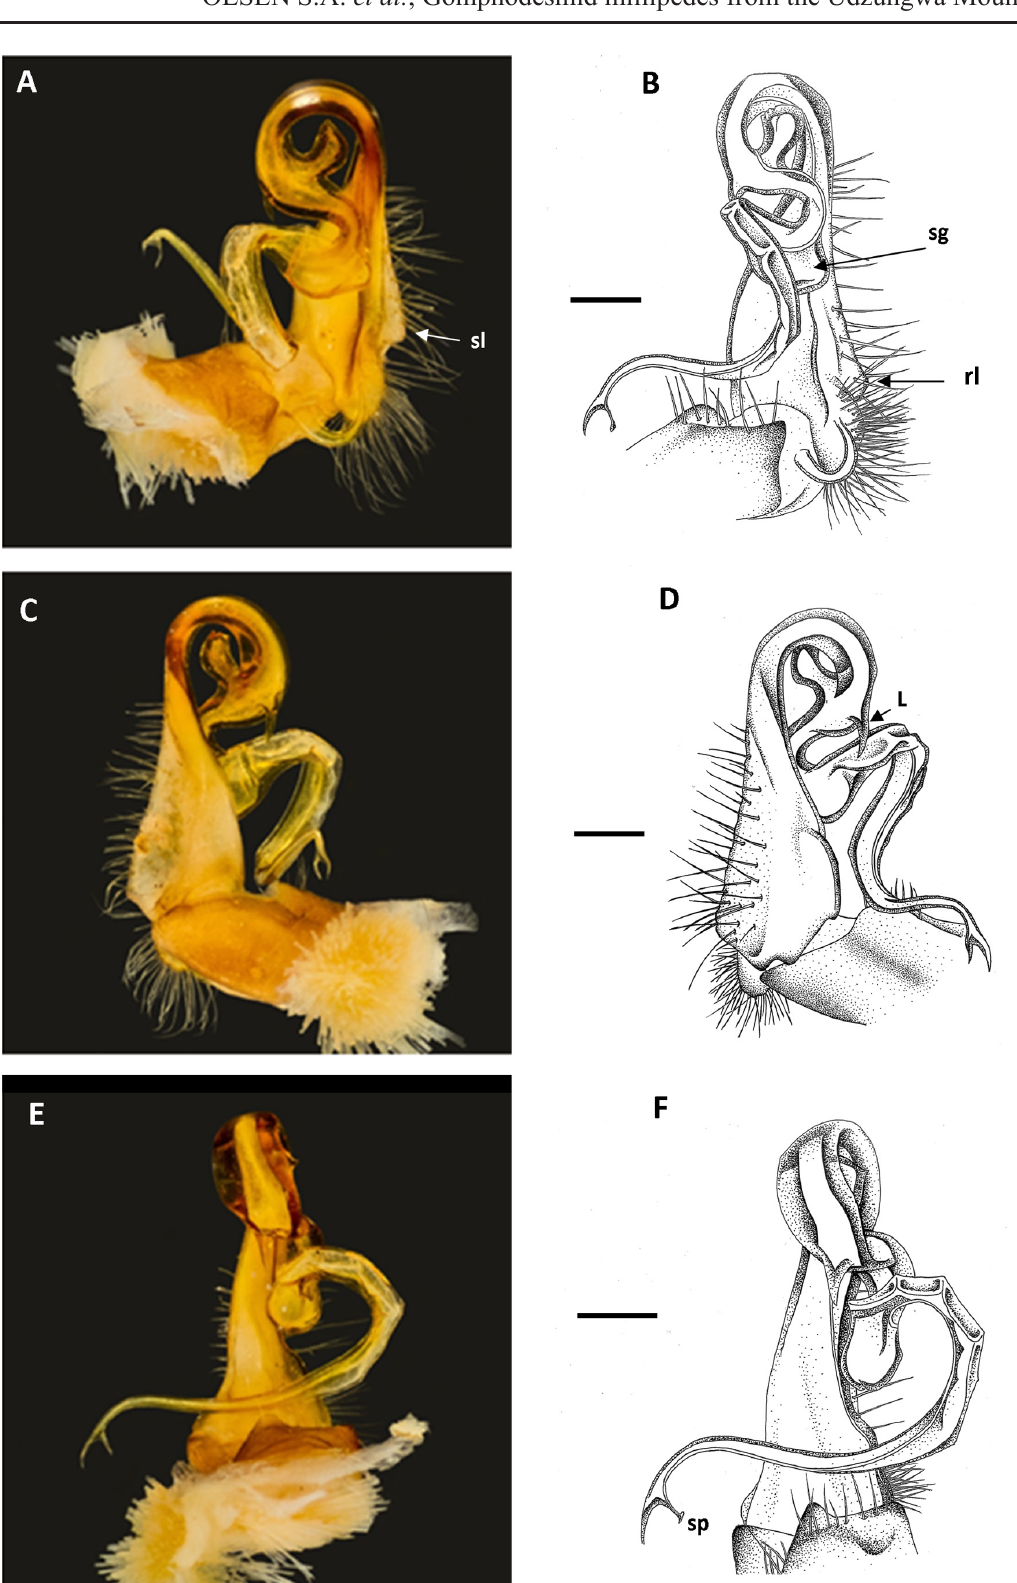
Fig. 14. Emphysemastic dracarys Olsen & Enghoff sp. nov., holotype, ♂, left gonopod (NHMD 621675). A–B . Mesal view. C–D . Lateral view. E–F . Dorsal view. Abbreviations: L = Process L; rl = rounded lobe; sg = subglobose enlargement; sp = subterminal process. Scale bars: 0.5